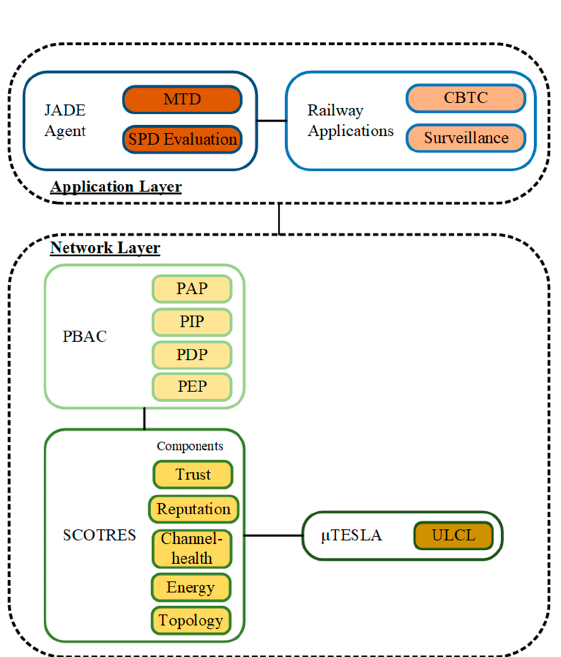
Figure 2. The building blocks of the SPD-Safe framework.